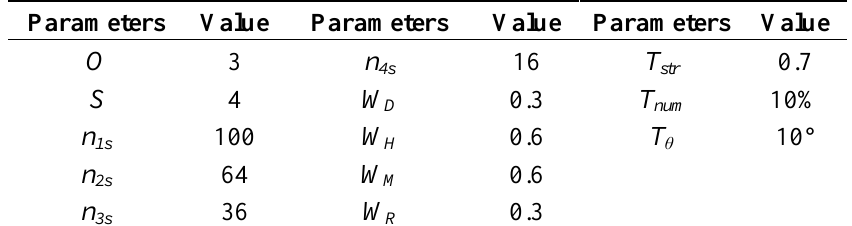
Table 1. Parameters in the proposed approach.